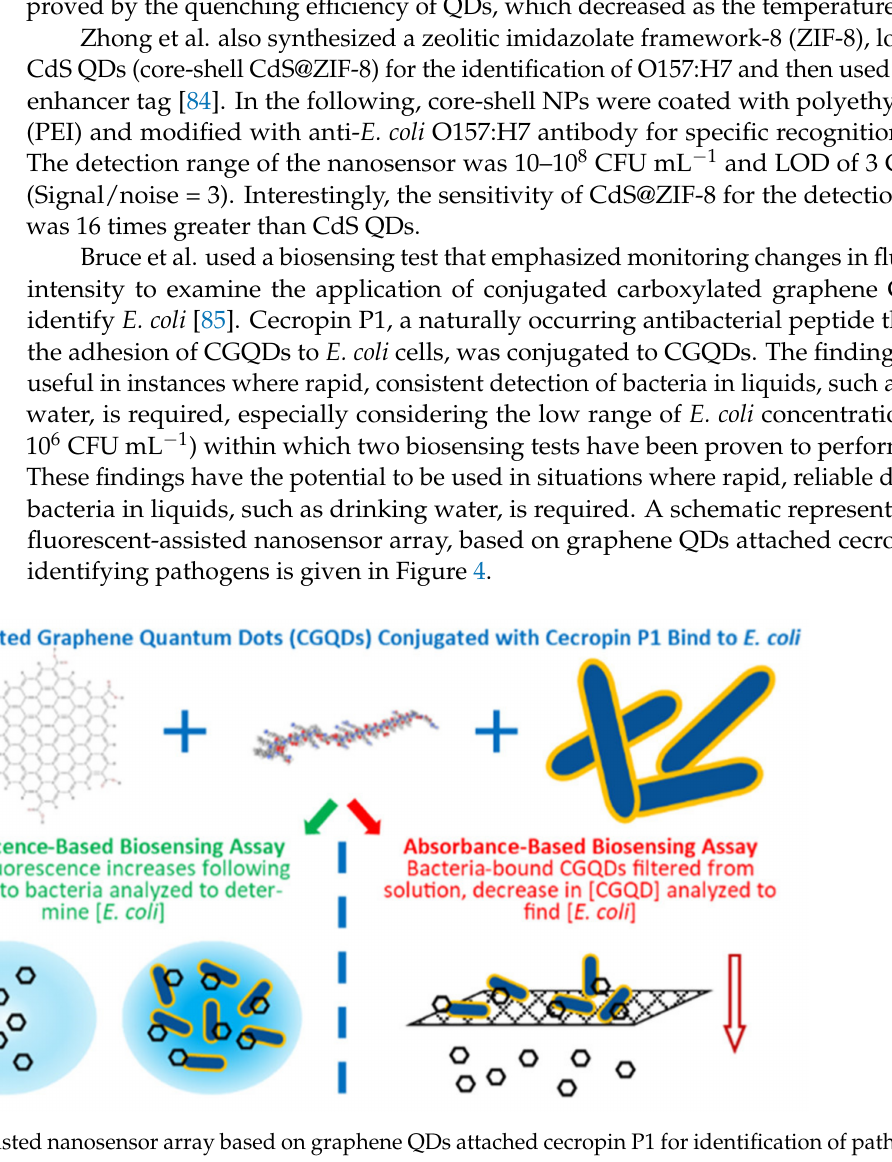
Figure 4. Fluorescent-assisted nanosensor array based on graphene QDs attached cecropin P1 for identification of pathogens. Reprinted from Ref.